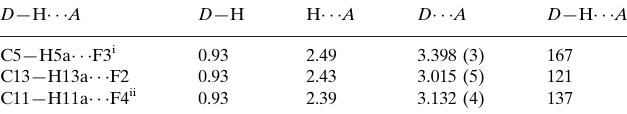
Data collection Bruker APEXII CCD area-detector diffractometer Absorption correction: multi-scan ( SADABS ; Bruker, 2007)